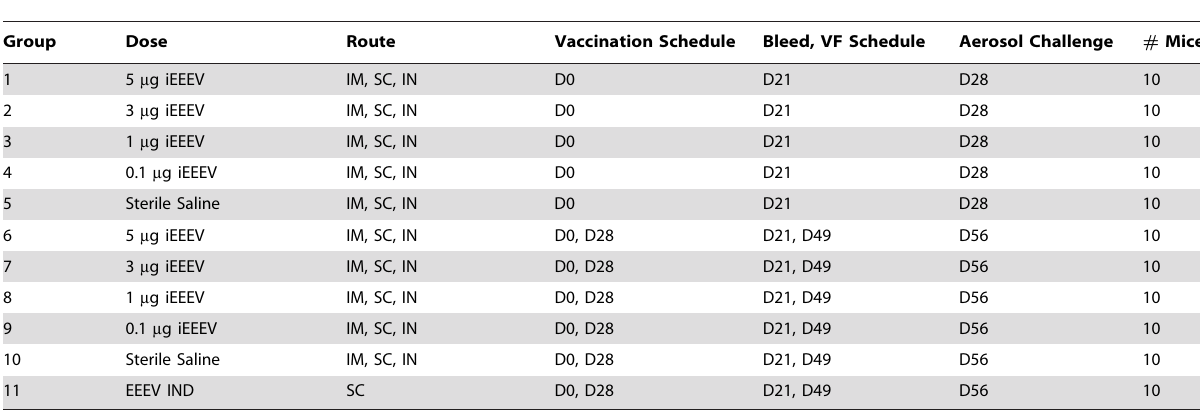
Table 1. Vaccine study design evaluating iEEEV candidates.